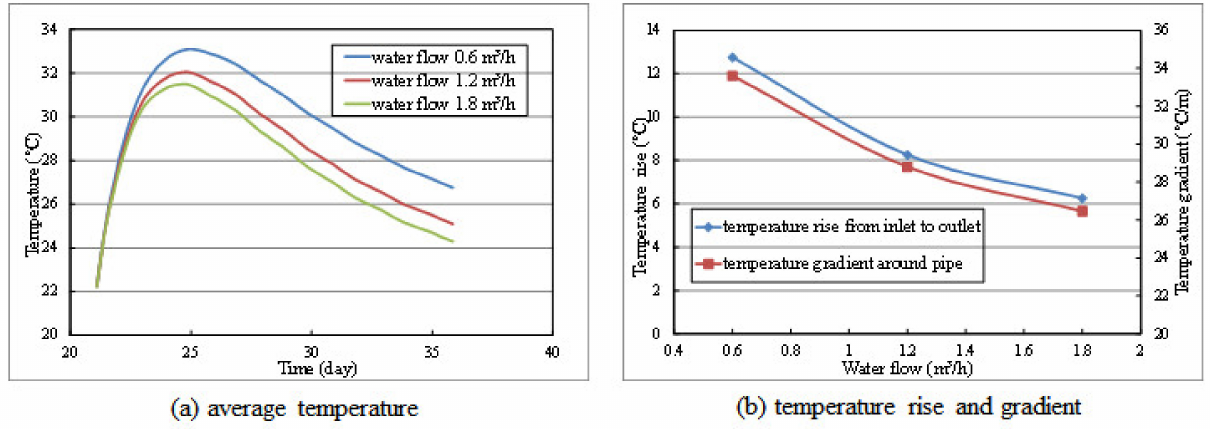
Figure 8. The calculation results of layer 2# under different water flow: ( a ) average temperature, ( b ) temperature rise and gradient.